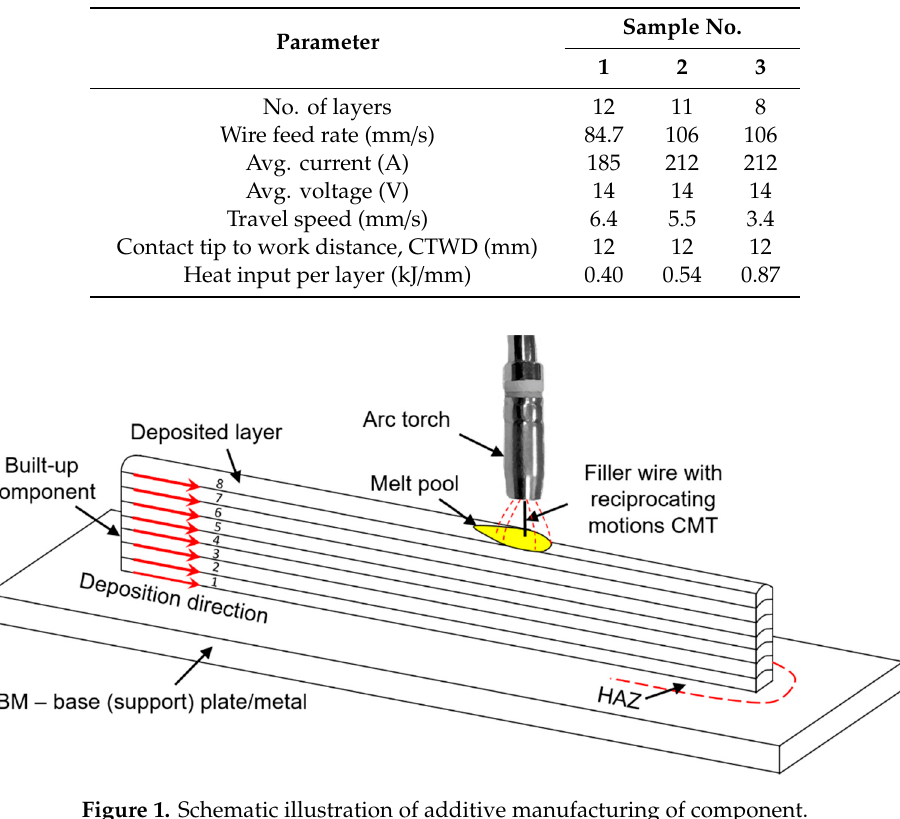
Figure 2. Mechanical testing of additively manufactured walls. Horizontal tensile samples to the left, vertical tensile specimens in the middle and Charpy V and CTOD (crack tip opening displacement) samples to the right. The latter two specimen types have different notches.